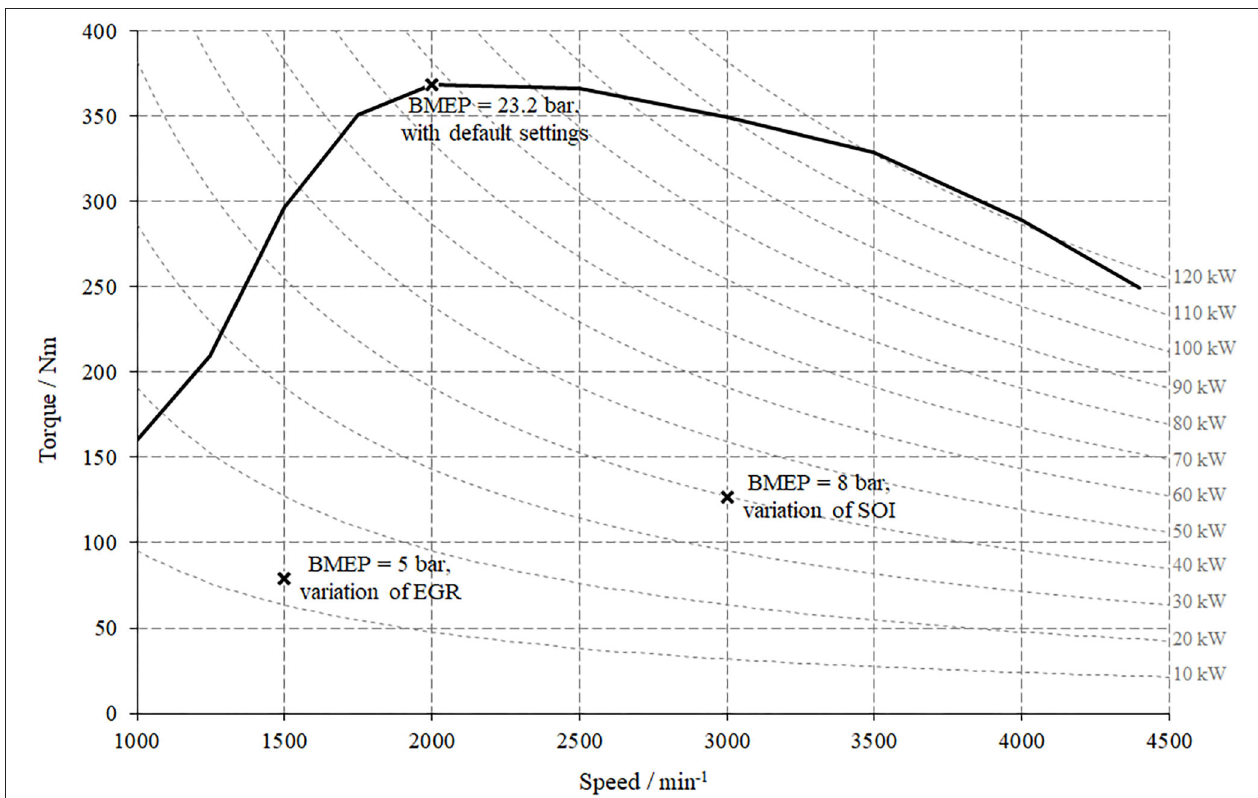
FIGURE 3 | Investigated operation points within the overall operation map of the test engine.